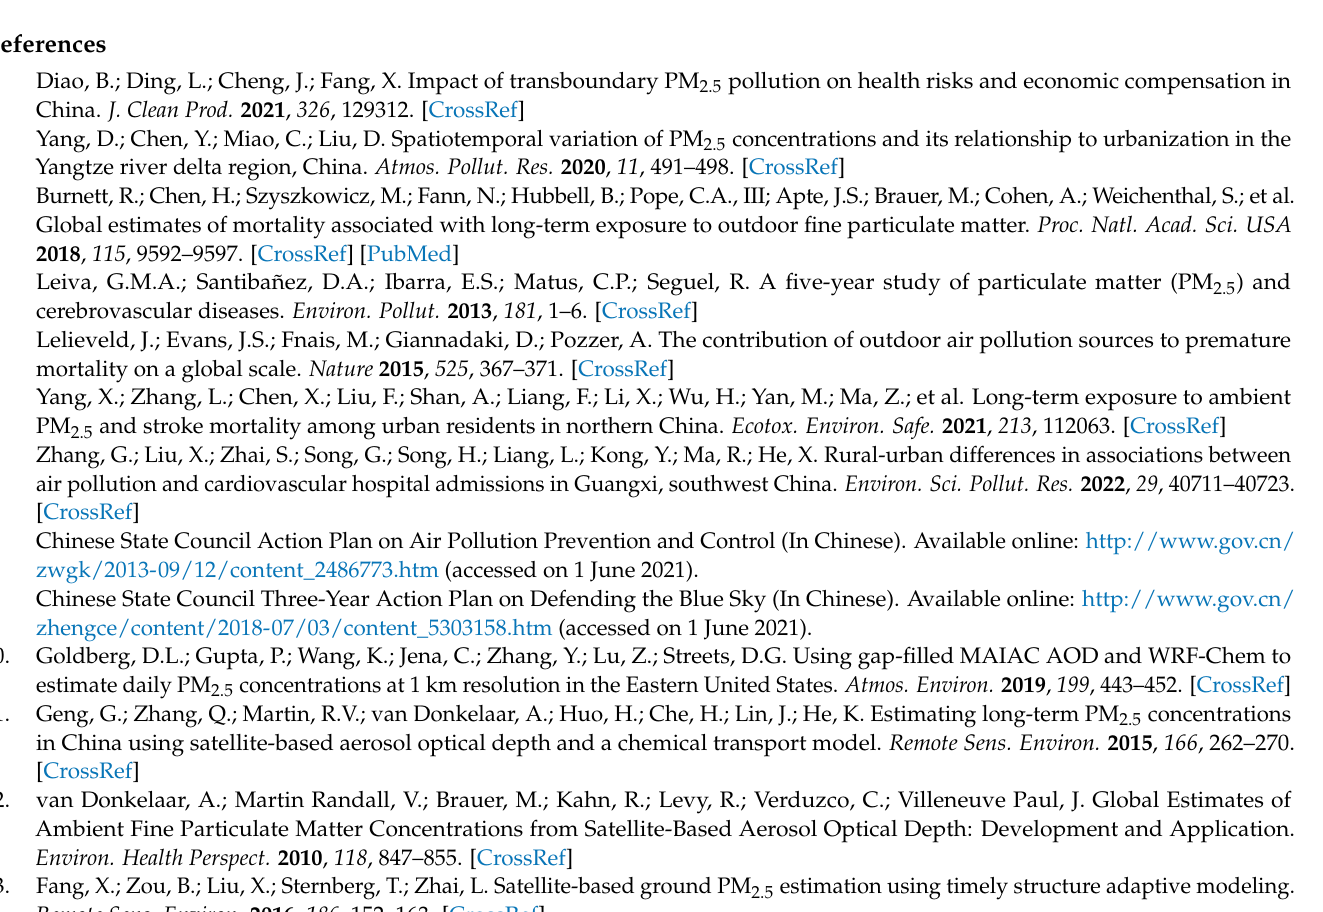
Table S1: Summary of the data used in this study; Table S2: The site-based validation results of Model 1 based on the valid AOD and gap-filled